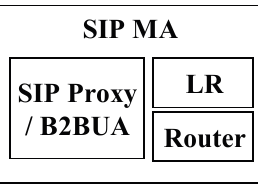
Figure 2. SIP MA.